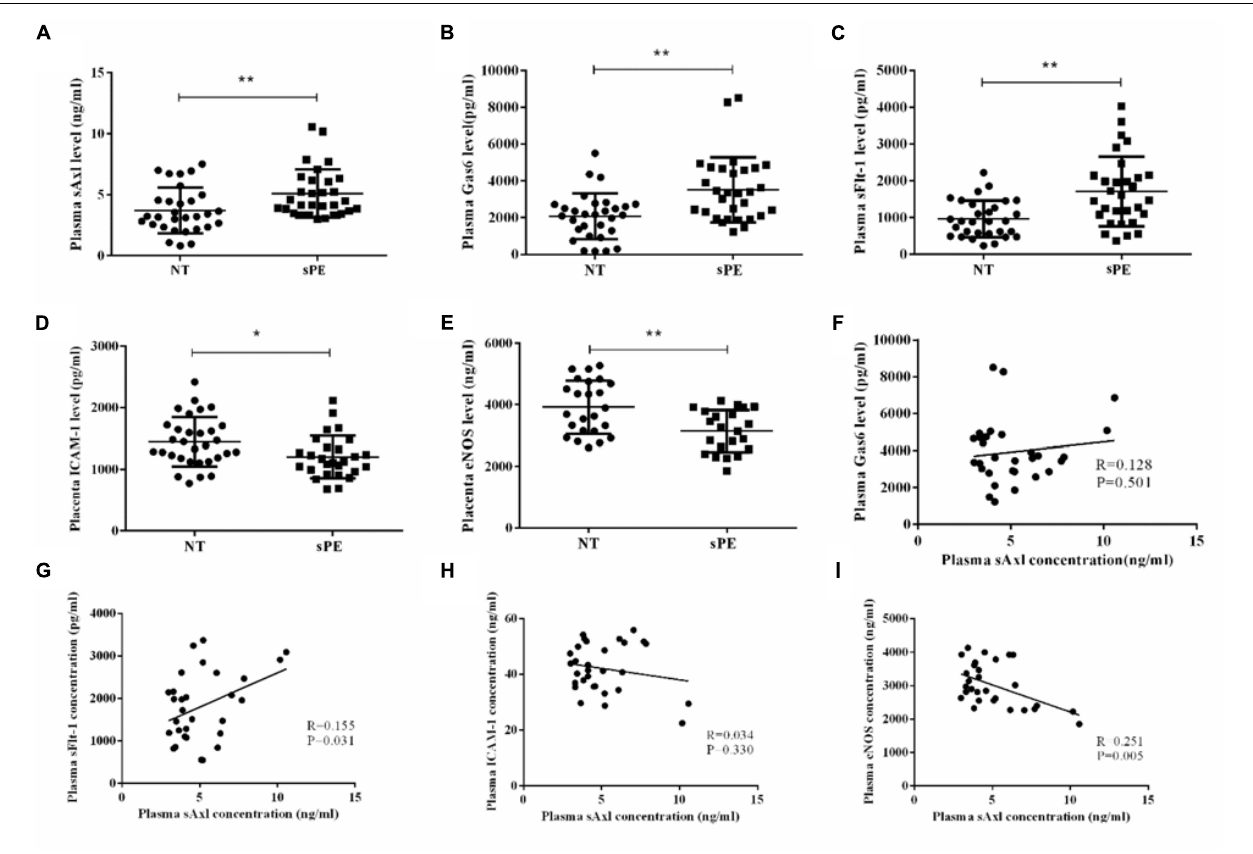
FIGURE 1 | The level of plasma sAxl and key molecules of angiogenesis in preeclampsia with severe features (sPE). (A–C) Plasma sAxl, Gas6, and sFlt-1 concentration were measured by ELISA in normal pregnants (NT) and sPE. (D,E) The ICAM-1 and eNOS levels in the homogenate of placental tissue were detected in women with NT and sPE. (F–I) Correlations between plasma sAxl and plasma Gas6, sFlt-1 and placental ICAM-1, eNOS. The results are presented as mean ± SD. * p < 0.05, ** p < 0.01 vs. respective controls. n = 30 per